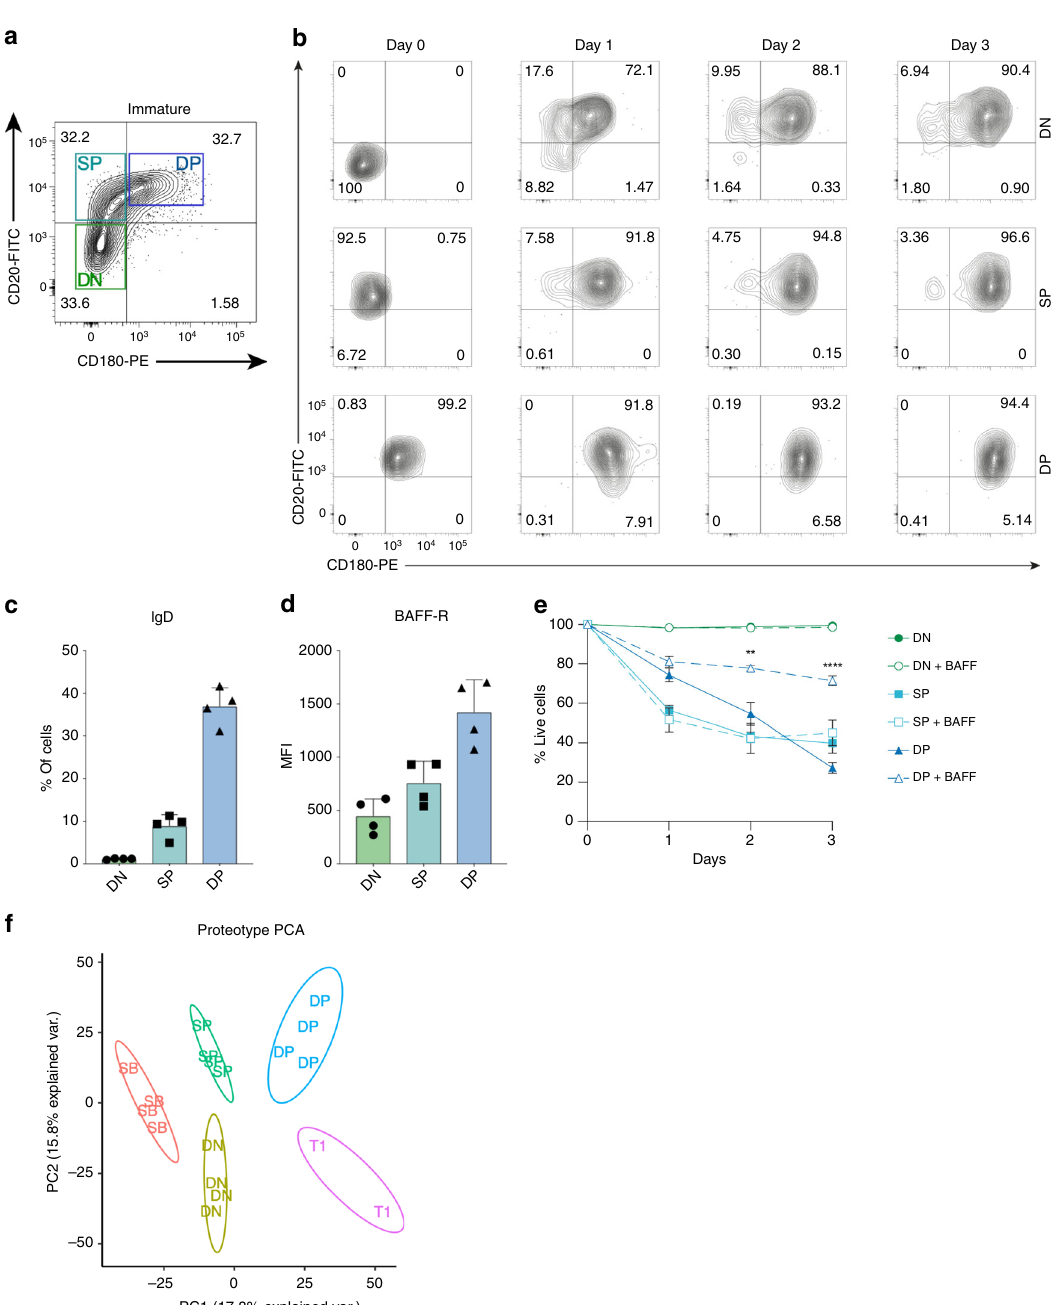
Fig. 3 Molecular and functional assessment of immature B subpopulations. a The immature B population was further divided into three subpopulations de fi ned by CD20 and CD180 fl uorescence intensity: double negative (DN), positive for CD20 (SP), and positive for both (DP). b In-vitro differentiation of the de fi ned immature B subpopulations during three days of culturing. c Fraction of IgD + cells in immature B subpopulations. d Mean fl uorescence intensity for BAFF receptor for the three immature B subpopulations. e Modulation of in vitro survival of subpopulations with BAFF treatment. f Principal component analysis of proteotype data re fl ects the identi fi ed immature B subpopulations. Error bars indicate standard deviation. Statistical analysis was done with two- tailed unpaired Student ’ s t test. One star indicates P < 0.01; four stars indicate P < 0.0001. NATURE COMMUNICATIONS| (2019) 10:5734